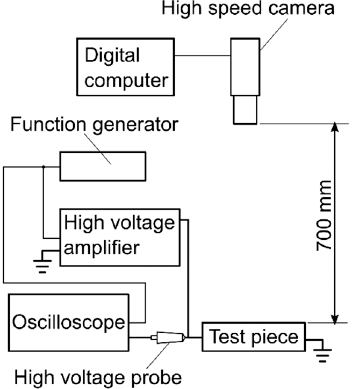
Figure 3. Apparatus for the measurement of electrostatic forces.